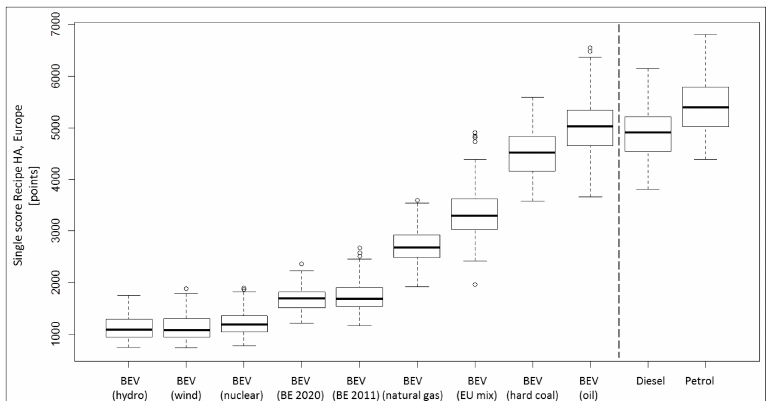
Figure 9. Influence of the electricity mix on single (eco) score (ReCiPe). Reproduced with permission from [28].